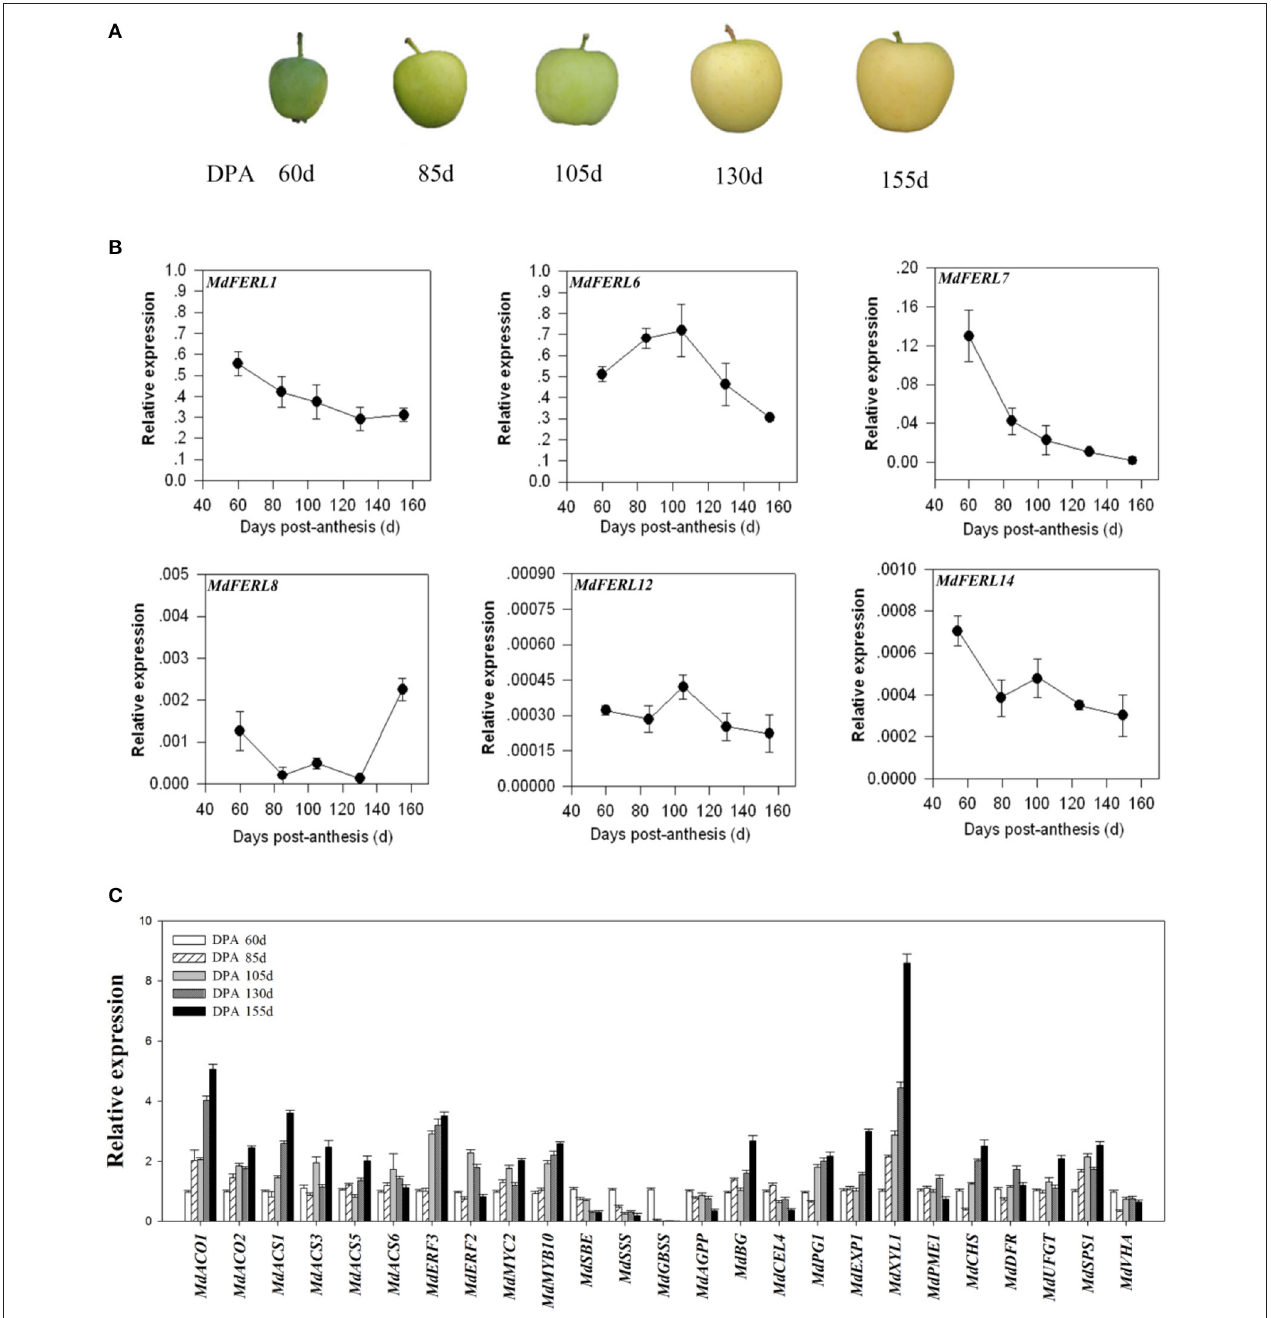
FIGURE 2 | Quantitative reverse transcription (RT-qPCR) analysis of gene expression in apple fruit at different developmental stages. (A) Phenotypes of apple fruit at different developmental stages: days post-anthesis (DPA) 60, 85, 105, 130, and 155 days. (B) Quantitative reverse transcription (RT-qPCR) analysis of MdFERL expression at different developmental stages. (C) Quantitative reverse transcription (RT-qPCR) analysis of the expression of ripening-related genes at different developmental stages. MdACTIN was used as an internal control. Values are means + SD of three biological